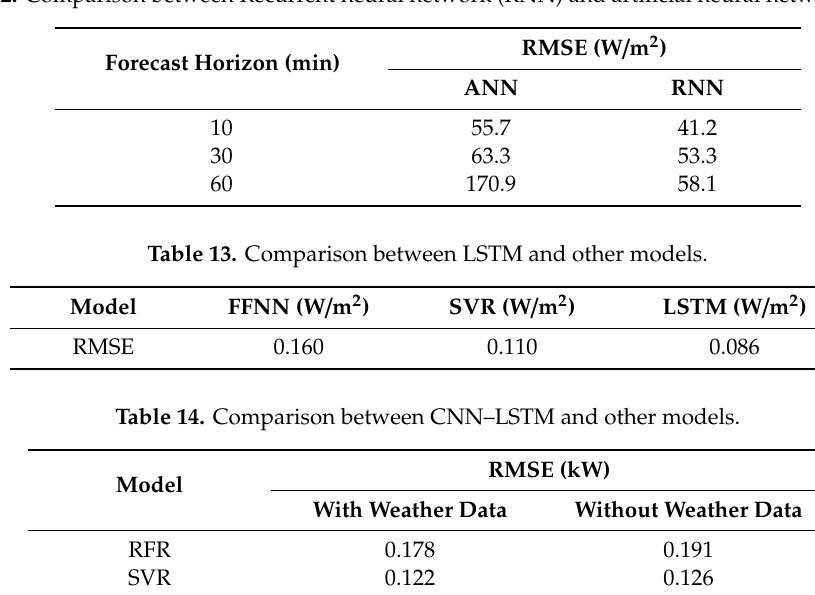
Table 12. Comparison between Recurrent neural network (RNN) and artificial neural network (ANN).